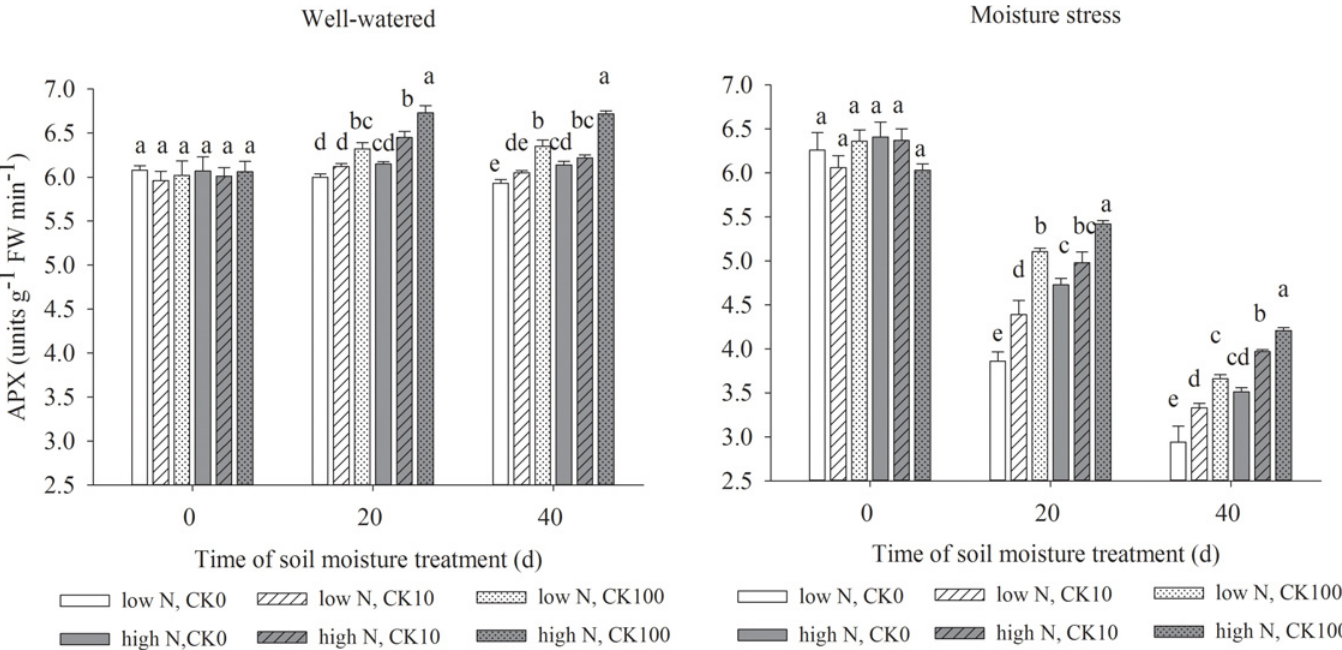
Fig 3. Activities of ascorbate peroxidase (APX) in leaves of drought stressed creeping bentgrass as affected by cytokinin trans -zeatin riboside (CK) and nitrogen. Bars having different letter indicate no significant enzyme activity difference (P < 0.05) between treatments on the same day.